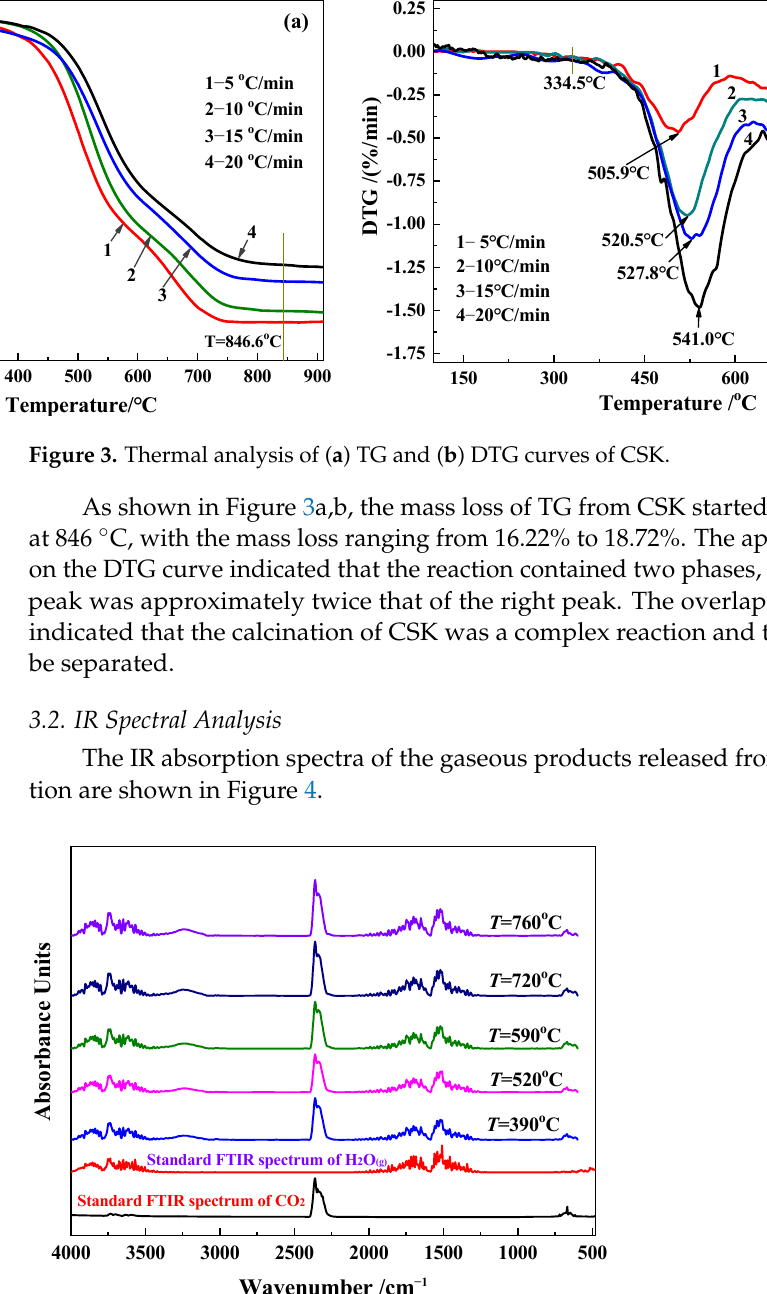
Figure 4. Infrared absorption spectrum of gas products (5 °C/min).